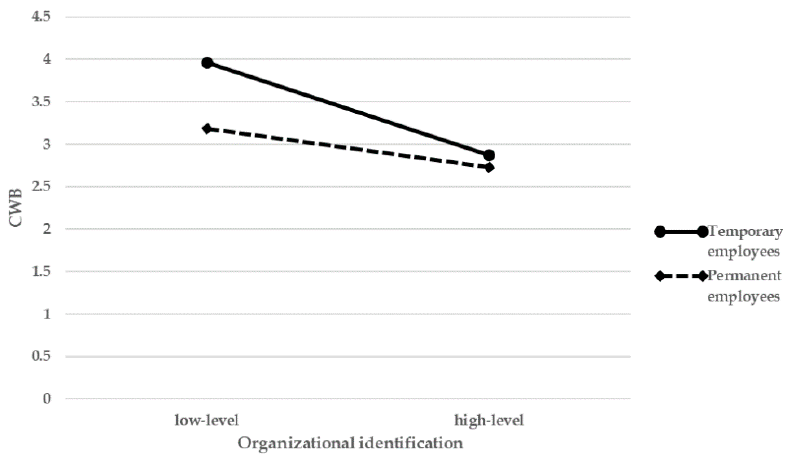
Figure 3. Interaction between organization identification and employment status on CWB.